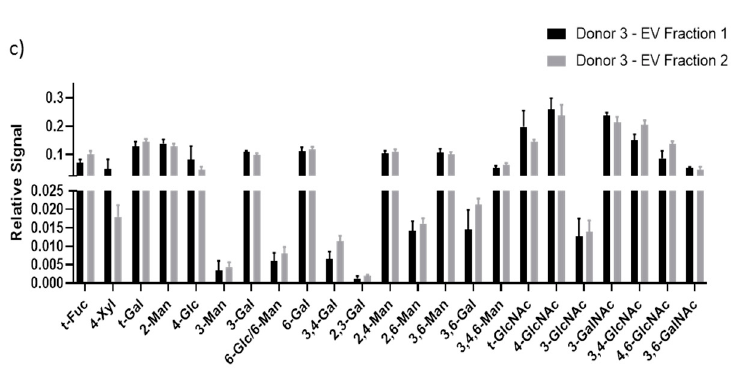
Figure 7. Comparison of EV fraction 1 (pooled elution fractions 7-9) and fraction 2 (pooled elution fractions 10–11) from each donor. Comparison of EV glycan nodes between SEC fractions 1 and 2 for each of three different donors ( a – c ). Data represent XIC peak areas for each hexose or HexNAc within each sample, that were normalized to the sum of all hexose or HexNAc XIC peak areas for that sample. For each glycan node, differences between fractions were searched for with a t-test, using the two-stage linear step-up procedure of Benjamini, Krieger, and Yekutieli, with Q = 0.1% to correct for false discoveries. No significant differences were observed. Data represent mean ± s.d. ( n = 4).